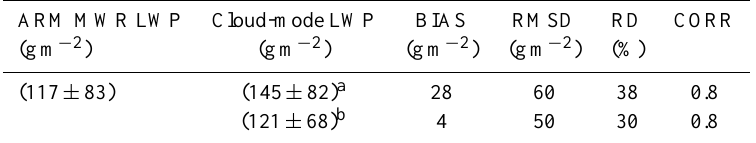
Table 4. Statistics for comparison of liquid water path (gm − 2 ) between the new cloud-mode retrievals and retrievals from the ARM mi- crowave radiometer (MWR) during May 2007–June 2008. Descriptions of these metrics can be found in Table 3 (but here BIAS is computed treating the MWR as truth). The ARM product used for this analysis is called MWRRET in the archive. Cloud-mode LWP is calculated from retrieved cloud optical depth and effective radius using two approaches.